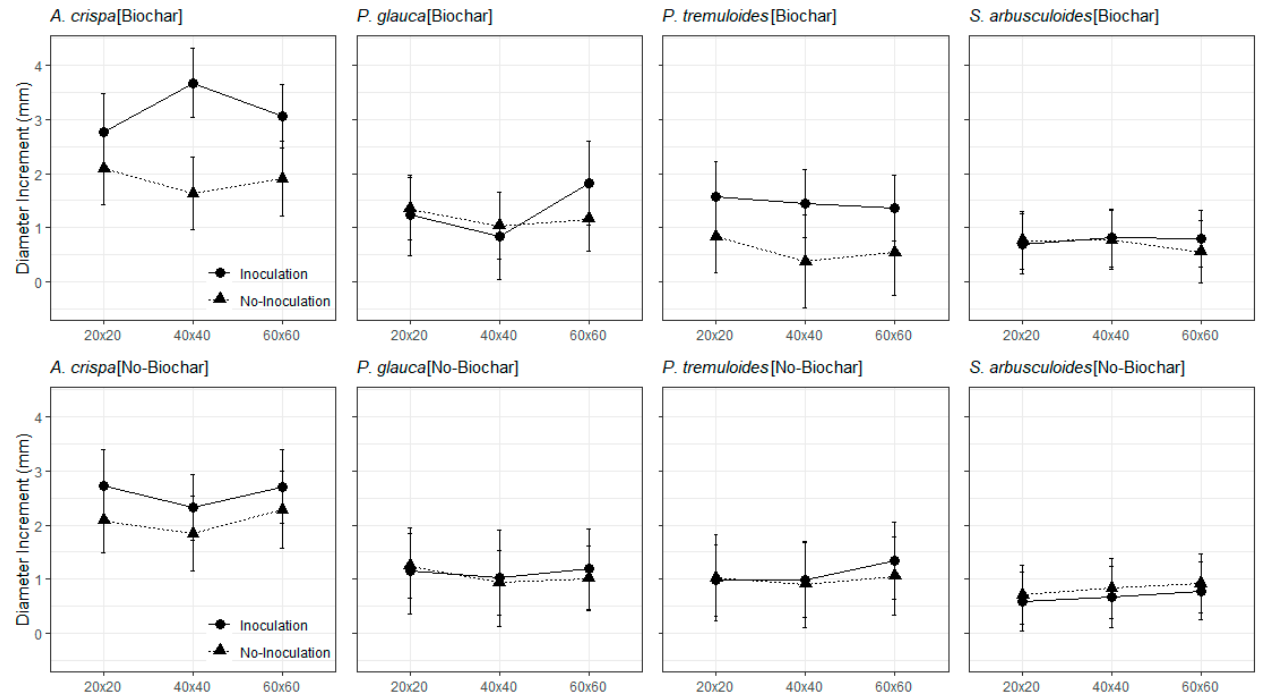
Figure 7. The interaction effect of biochar, inoculation, and spacing treatments in the fine tailing site. The error bars represent the 95% confidence interval (CI) of means.